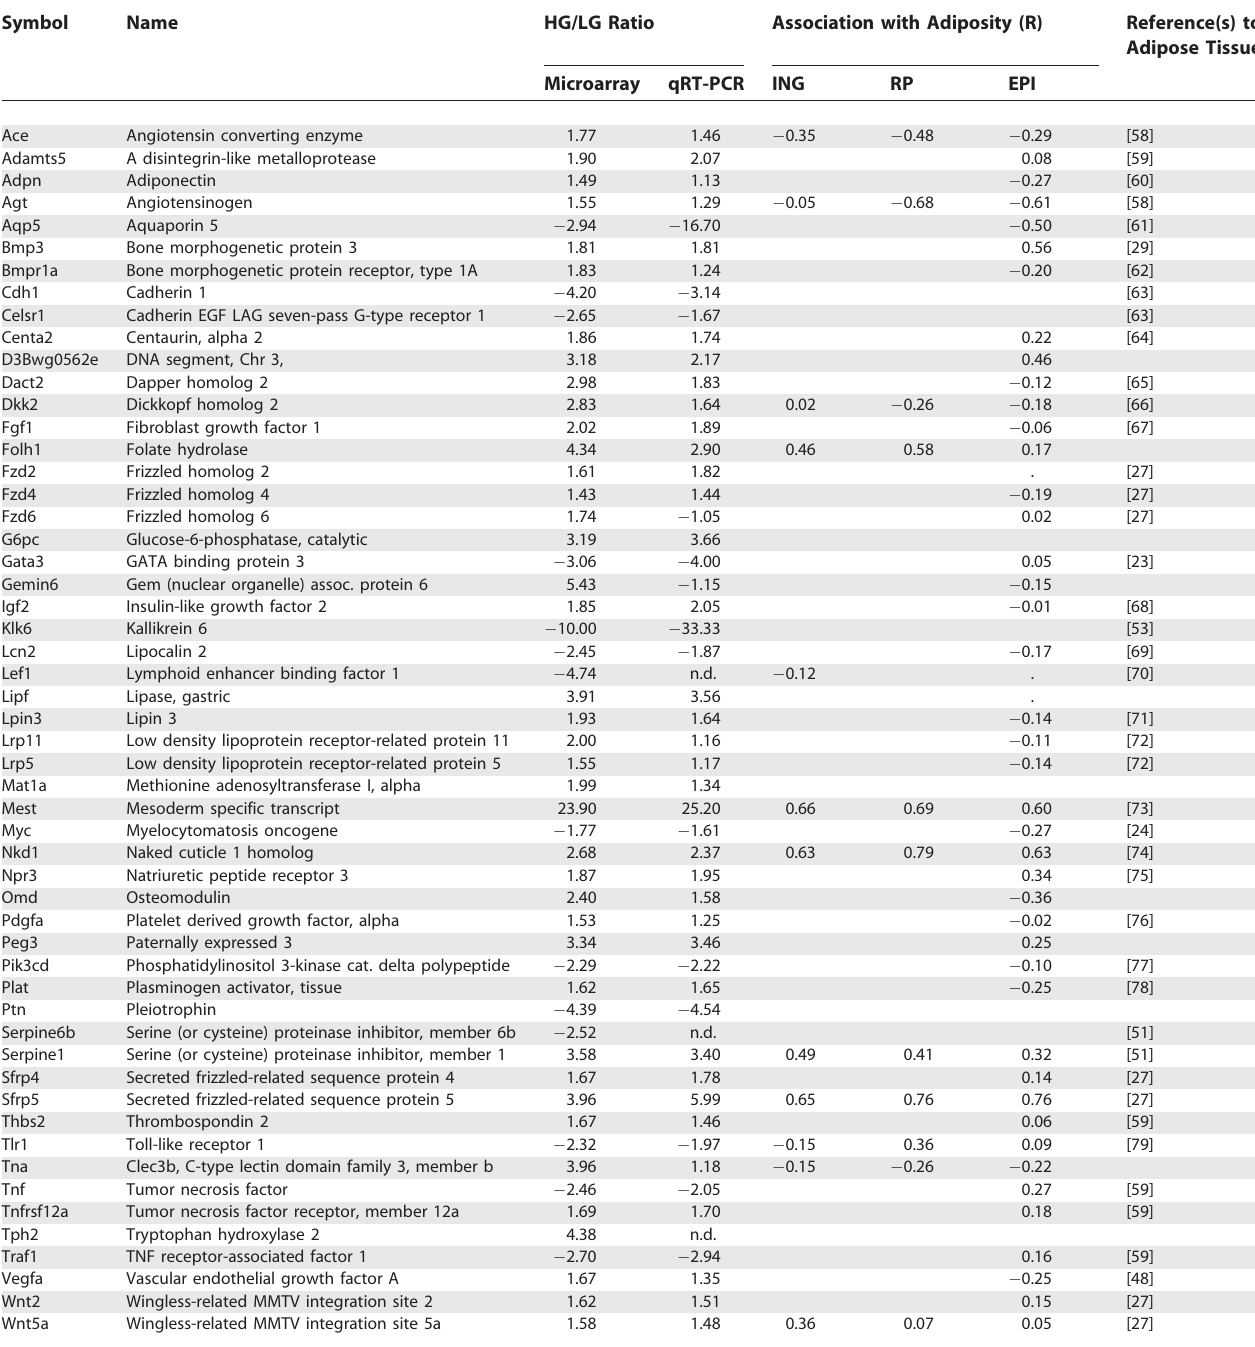
Table 1. Validation of Microarray Gene Expression Data